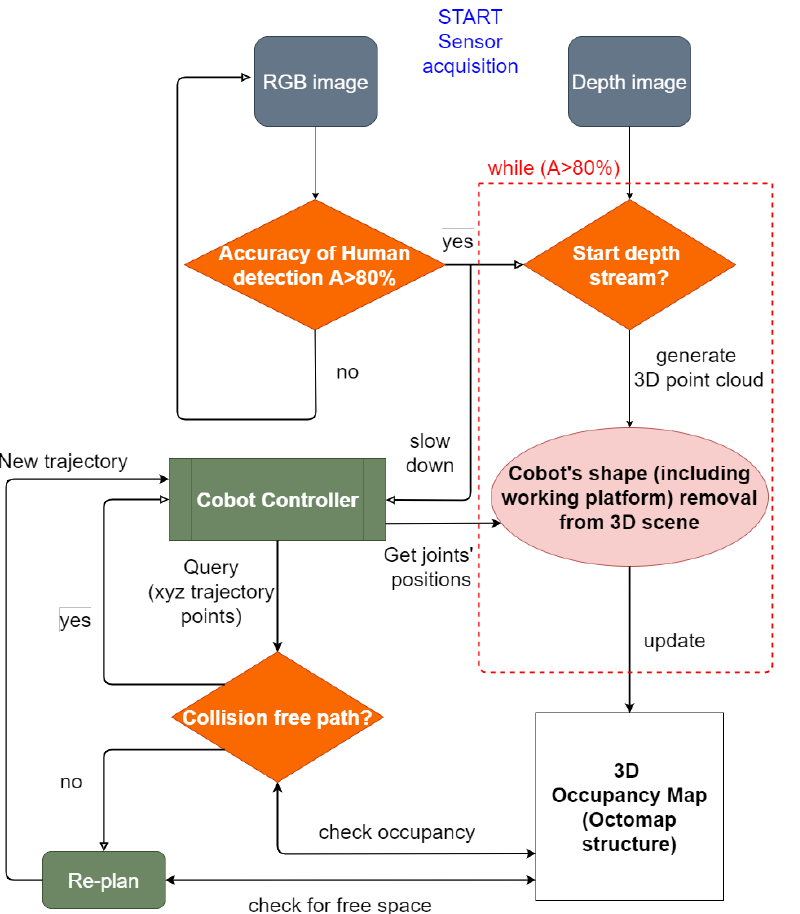
Figure 6. Block diagram representing the logical workflow and algorithms’ interaction of the